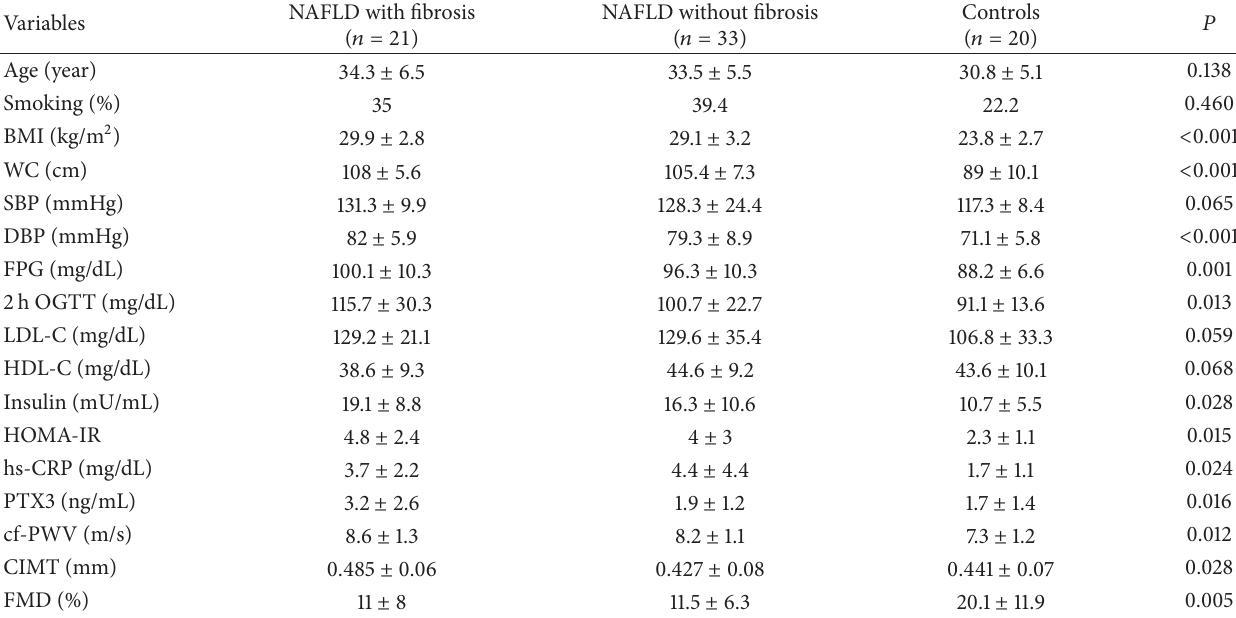
Table 2: The assessment of vascular and metabolic parameters according to the presence of fibrosis.